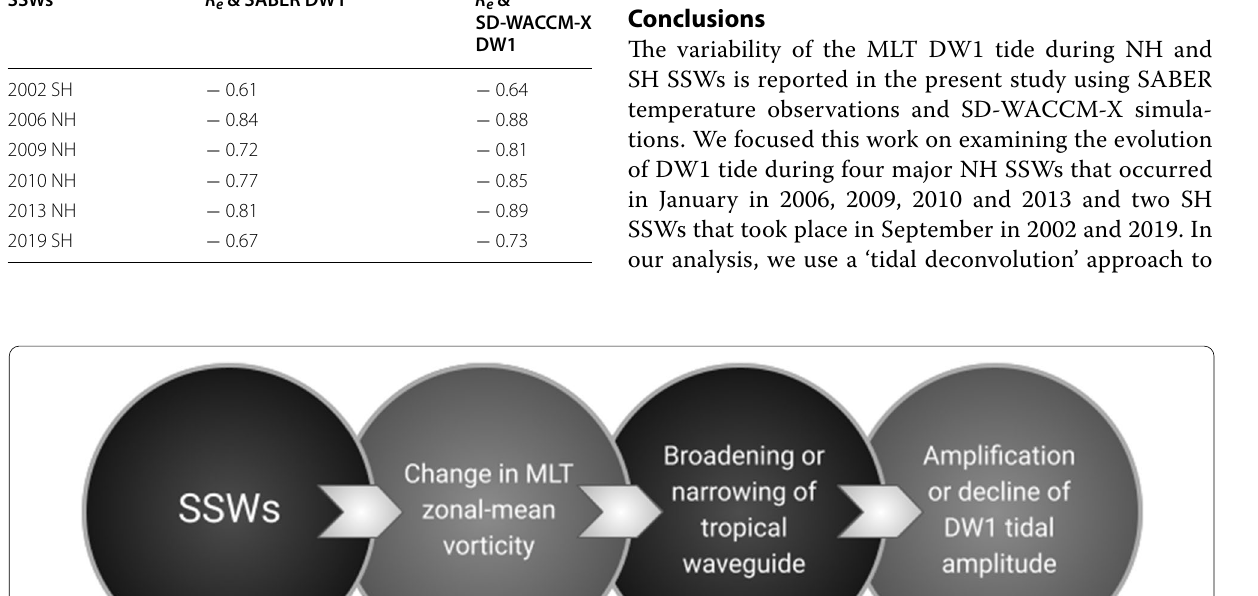
Table 2 Pearson’s correlation coefficient ( r ) between R e and mean DW1 tidal amplitudes from SABER and SD-WACCM-X for the listed NH and SH SSWs SSWs